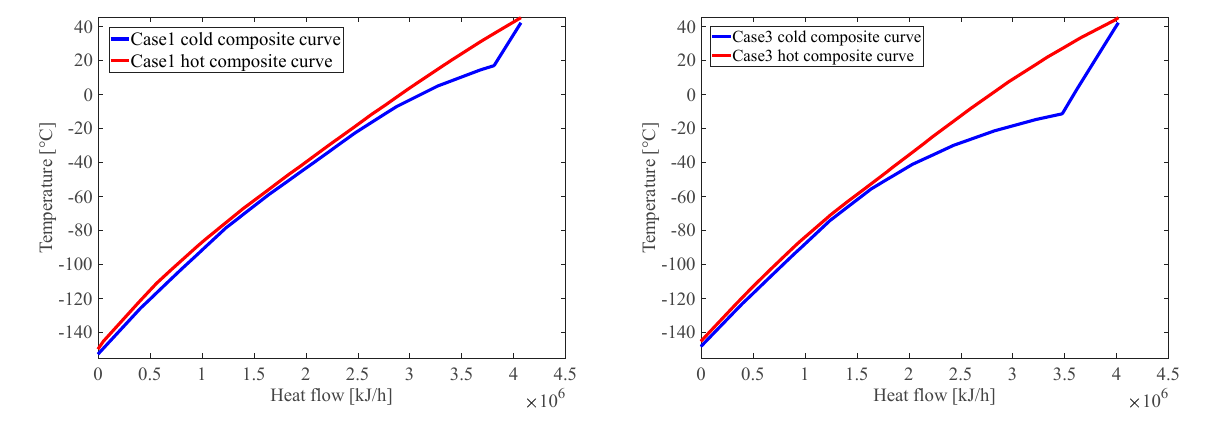
Figure 4. Heat curve of case 1 ( left ) and case 3 ( right ).